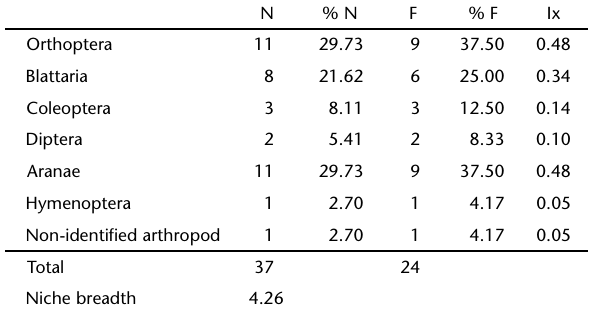
Table III. Number (N), percentage (% N), frequency (F), frequency in percentage (% F) and importance index (Ix) of prey categories in the diet of Micrablepharus maximiliani from the Estação Ecológica Uruçuí